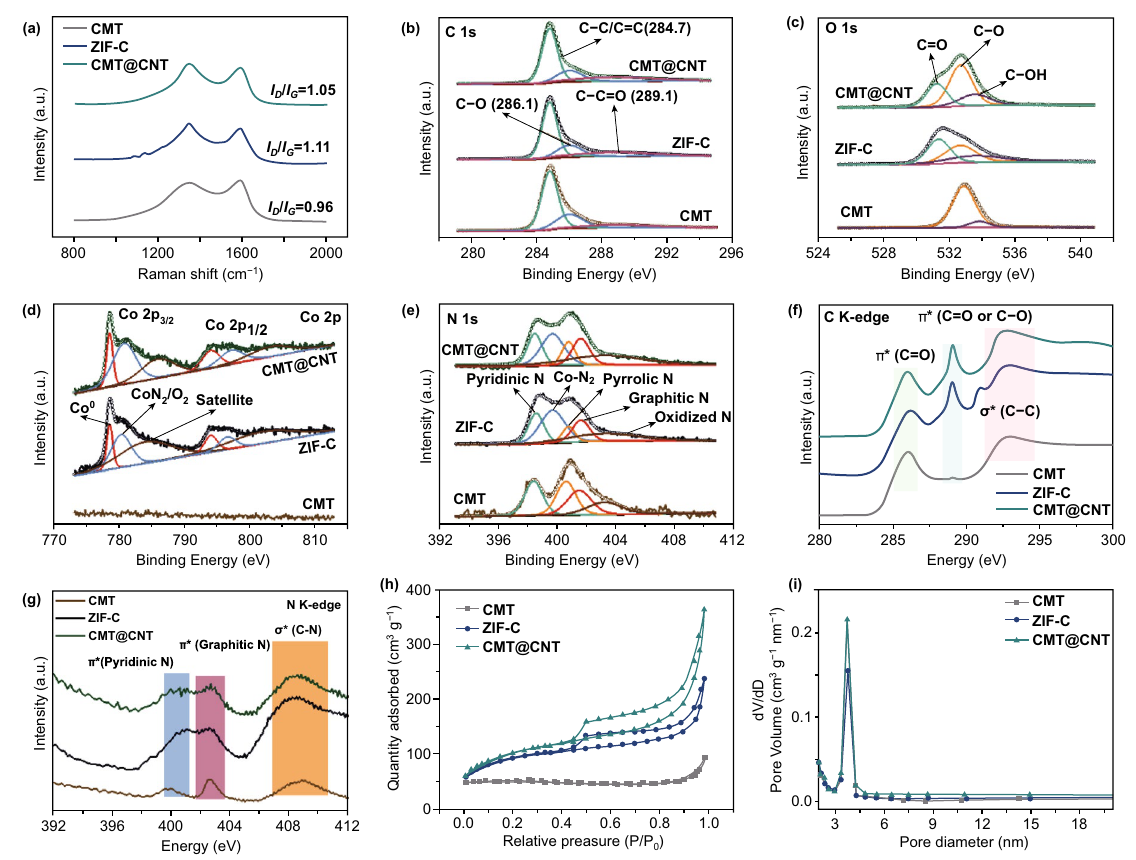
Fig. 2 a Raman spectra, High-resolution XPS spectra of b C 1s, c O 1s, d Co 2p, and e N 1s, f C K-edge, and g N K-edge XANES, h N 2 sorp- tion isotherm, and i pore size distribution plots of CMT@CNT, ZIF-C, and